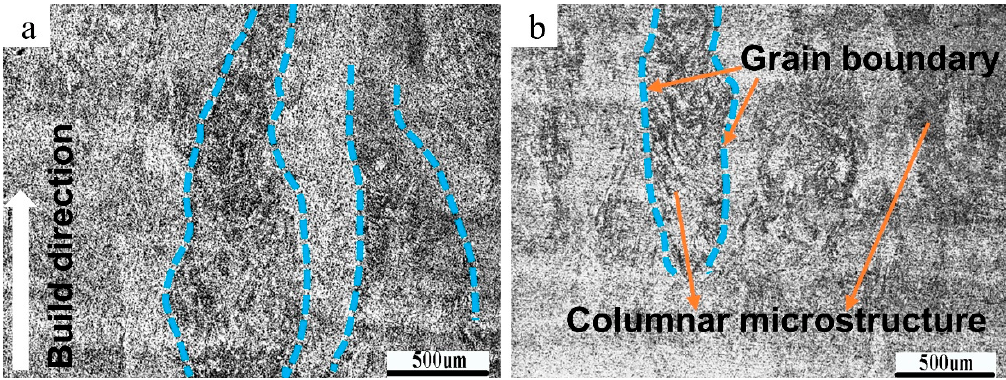
Figure 9. Effect of line offset on the columnar crystals morphology of Ti-6Al-4V alloy: ( a ) 0.16 mm; ( b ) Figure 9. E ff ect of line o ff set on the columnar crystals morphology of Ti-6Al-4V alloy: ( a ) 0.16 mm; 0.28 mm. ( b ) 0.28